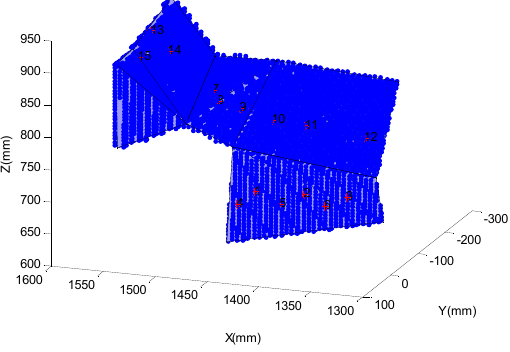
Figure 4. The environment model using the grid method, red spots: weld joints, blue area: grid matrix.